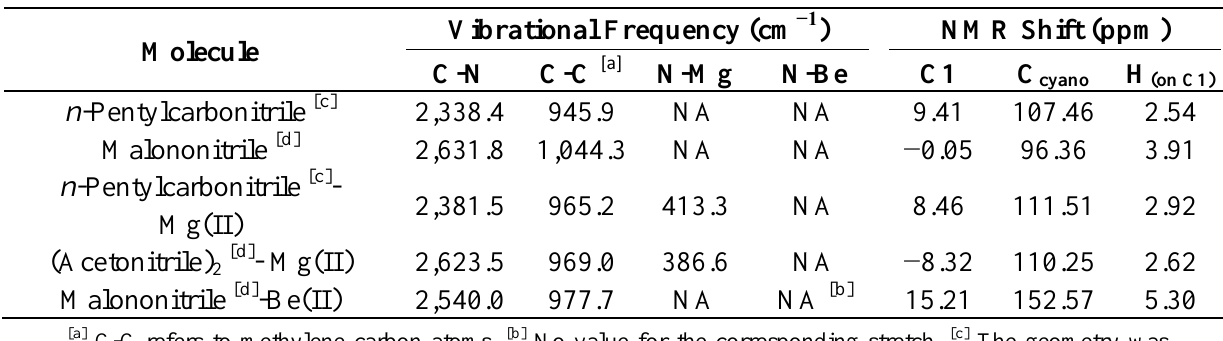
( i ) n -Pentylcarbonitrile ( ii ) n -Pentylcarbonitrile-Mg(II) Table 11. Vibrational frequencies and NMR shifts of Mg(II) and Be(II) complexes with n -pentylcarbonitrile, two equivalents of acetonitrile, malononitrile and the uncomplexed